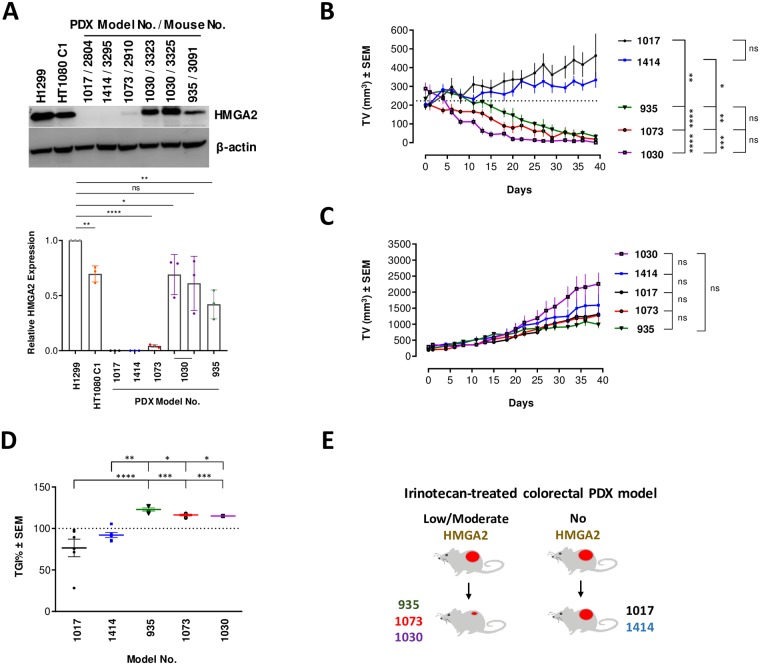
Low-to-moderate HMGA2 expression increases irinotecan chemosensitivity of PDX models.(A) Western blot using anti-HMGA2 antibody Ab41878 exhibiting high HMGA2 detection sensitivity (top panel). HMGA2 expression from representative propagated tumors (indicated by the corresponding mouse number) from each PDX model before inoculation into the treatment groups (two independently propagated samples are shown for model no 1030). We compared their HMGA2 expression levels with two cancer cell lines as standards for SN38 sensitivity: H1299 cells, which exhibit a degree of SN38 resistance due to high HMGA2 levels, and HT1080 C1 cells, which exhibit SN38 sensitivity due to low/moderate HMGA2 levels. The complete set of propagated tumors for each PDX model chosen for treatment is shown in S6 Fig and indicated as mouse no. Quantification (bottom panel) of HMGA2 expression relative to H1299 (set as 1) using ImageJ software (n = 3 independent experiments). Error bars show SD. Unpaired two-tailed t-tests. * p < 0.05, ** p < 0.01, **** p < 0.0001. (B) Tumor growth kinetics (Day 0 to Day 39) of five PDX models (n = 6 animals/model) in Irinotecan treatment group. Dotted lines indicate mean starting volume of all PDX models. Two-way ANOVA followed by Tukey’s multiple comparisons. Error bars show SEM. * p < 0.05, ** p < 0.01, *** p < 0.001, **** p < 0.0001. (C) Tumor growth kinetics (Day 0 to Day 39) of five PDX models (n = 6 animals/model) in vehicle group. Two-way ANOVA followed by Tukey’s multiple comparisons. Error bars show SEM. ns not significant. (D) Tumor growth inhibition (TGI) of each PDX model at day 39 (Plotted as percentage). TGI is calculated taking the physiological growth of the tumor (vehicle group) into account. Dotted lines indicate 100% TGI level. Two-way ANOVA followed by Tukey’s multiple comparisons. Error bars show SEM. * p < 0.05, ** p < 0.01, *** p < 0.001, **** p < 0.0001. (E) Graphical representation of the correlation between HMGA2 expression and tumor outcomes due to irinotecan treatment in colorectal PDX models used in the study.